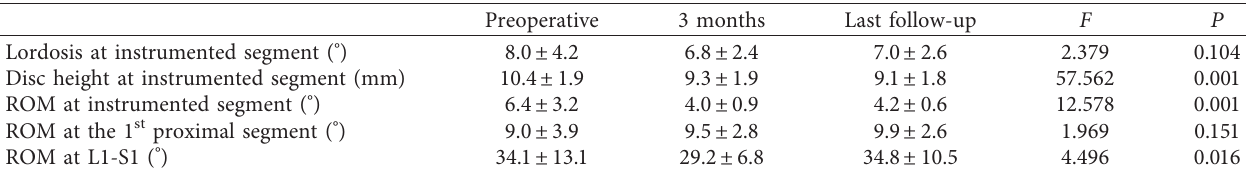
Table 3: Radiographic